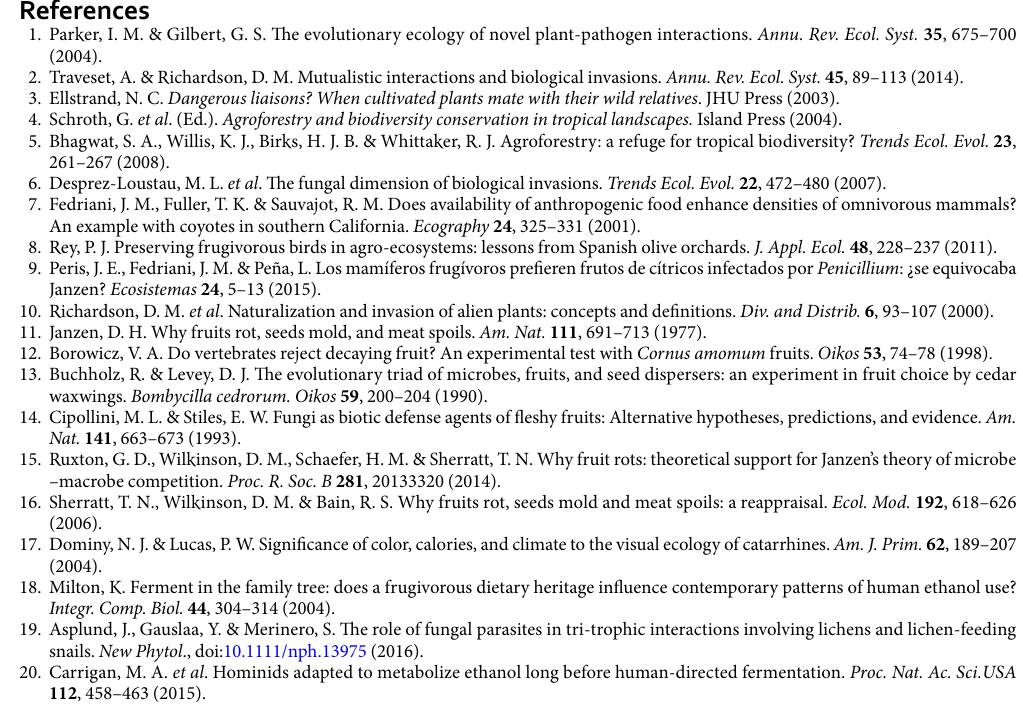
7 Scientific RepoRts | 7: 5646 | DOI:10.1038/s41598-017-05643-z